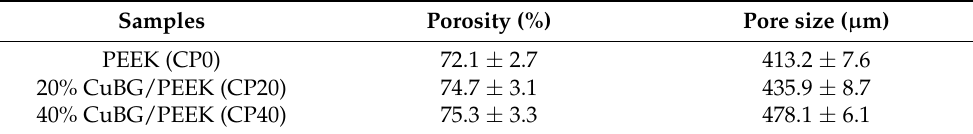
Table 1. The porosity of scaffold materials with different percentages of CuBG.